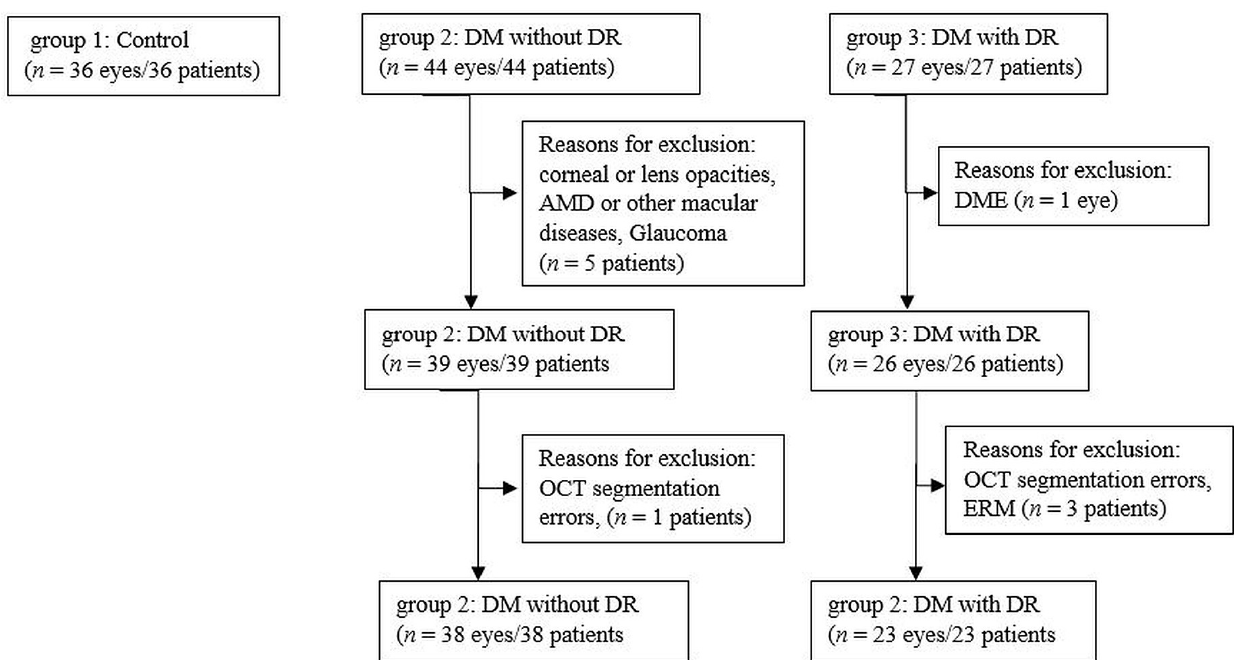
Figure 1. Flow diagram illustrating the study selection process. n, number; DM, diabetus mellitus; DR, diabetic retinopathy; AMD, age-related macular degeneration; OCT, optical coherence tomography; DME, diabetic macular edema; ERM, epiretinal membrane.